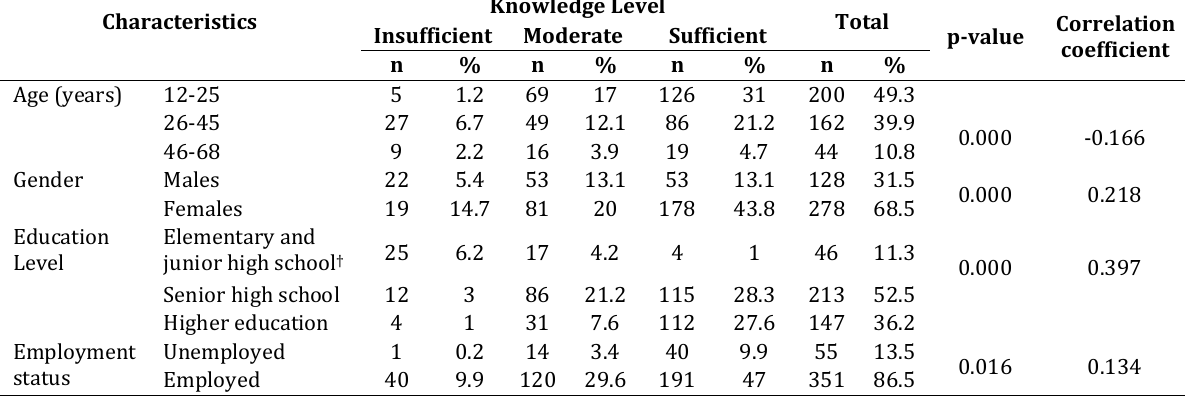
Table 3. The Relationship between R espondents’ Characteristics and Knowledge Level against COVID-19 Characteristics